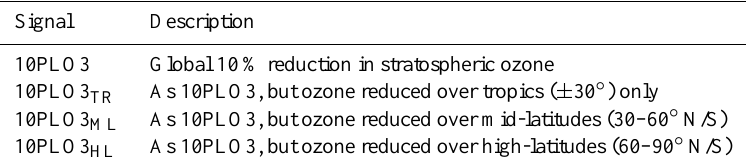
Table 1. Stratospheric cooling experiments.